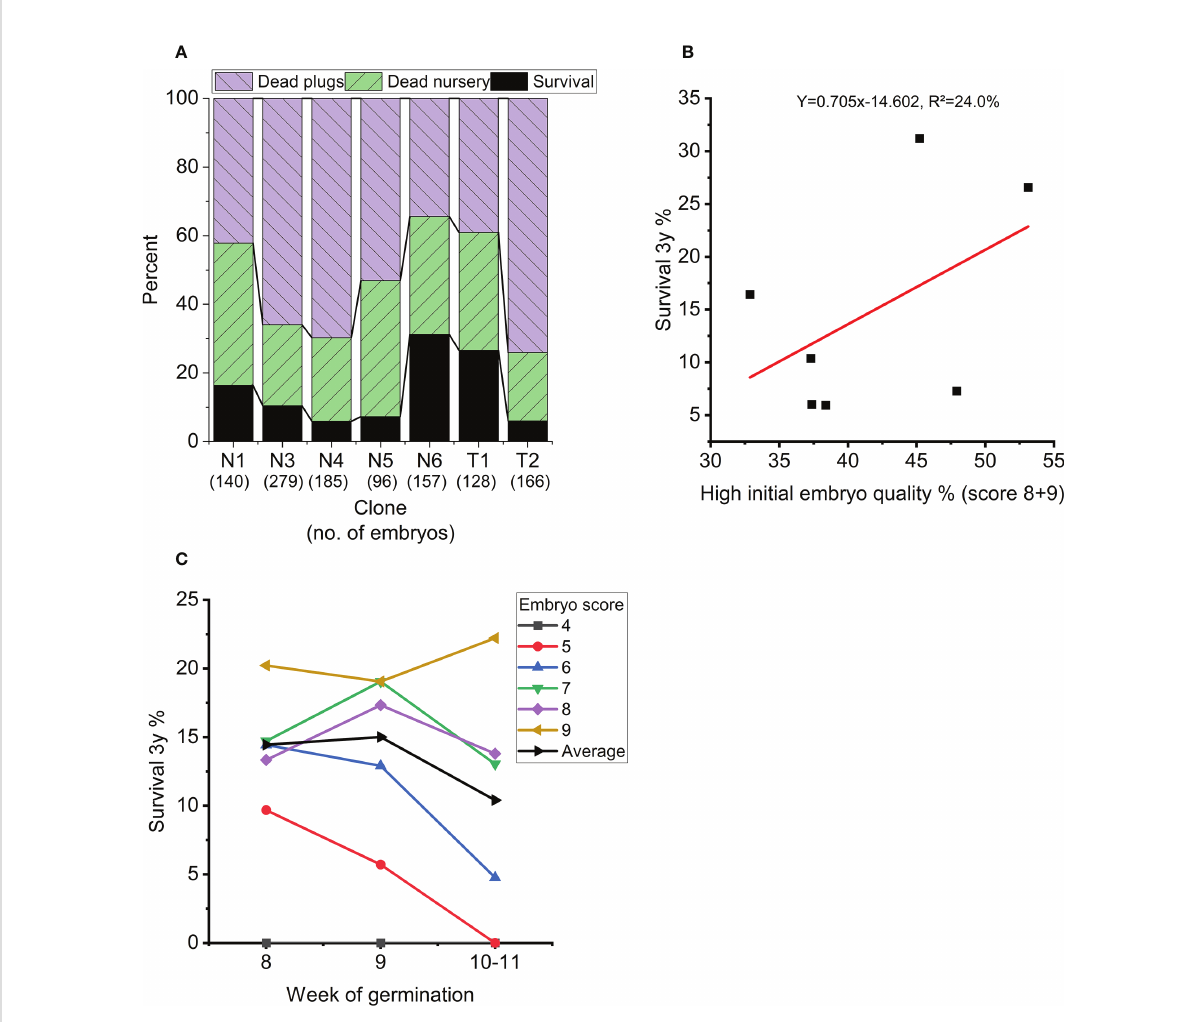
FIGURE 6 (A) Average survival for each clone in percentage at the end of nursery growth (black), mortality during 8 weeks of plant growth in plugs (blue) and 3 years of plant growth in the nursery (green). (B) Average survival of each clone (at the end of nursery growth) as a function of percentage high quality embryos (score 8-9) across all treatments. (C) Average survival across treatments at the end of nursery growth as a function of week of germination (dashed line) and for each initial embryo score (average across all clones and treatments). Weeks 10 and 11 are grouped together due to few